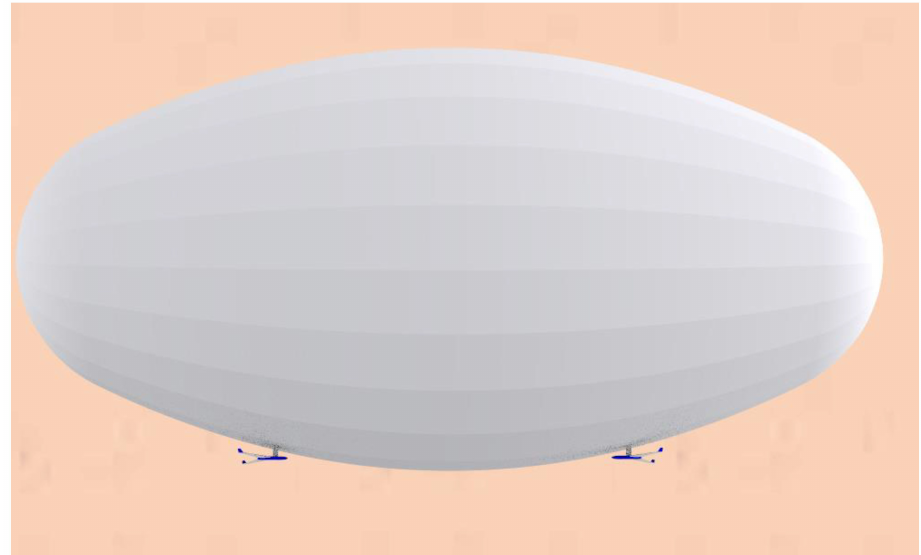
Figure 15. Pair of Mars Sailplanes mounted to a blimp (drawn to